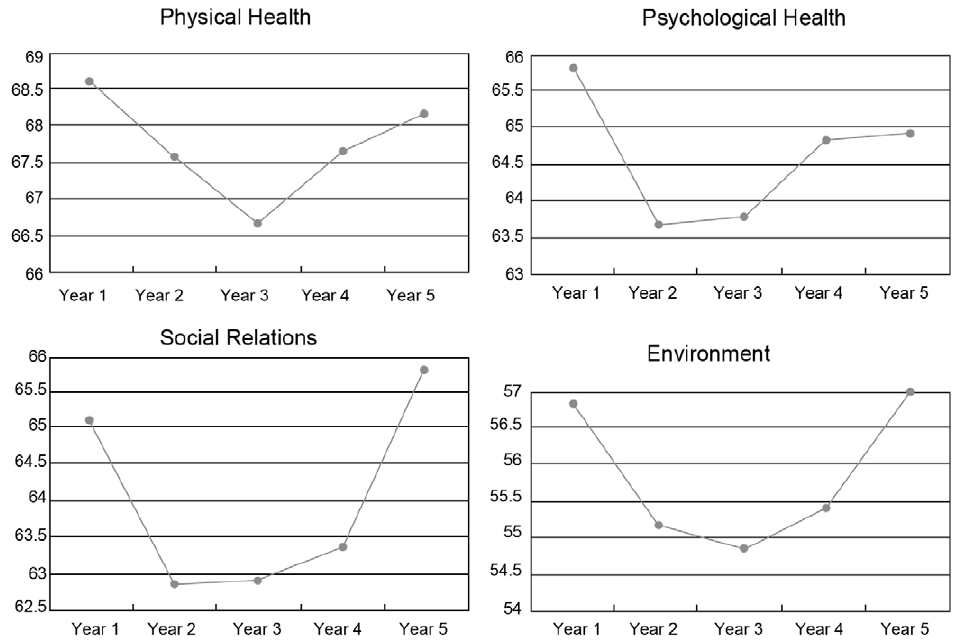
Figure 2. Scores of each domain for clinical medicine. doi:10.1371/journal.pone.0049714.g002 PLOS ONE |